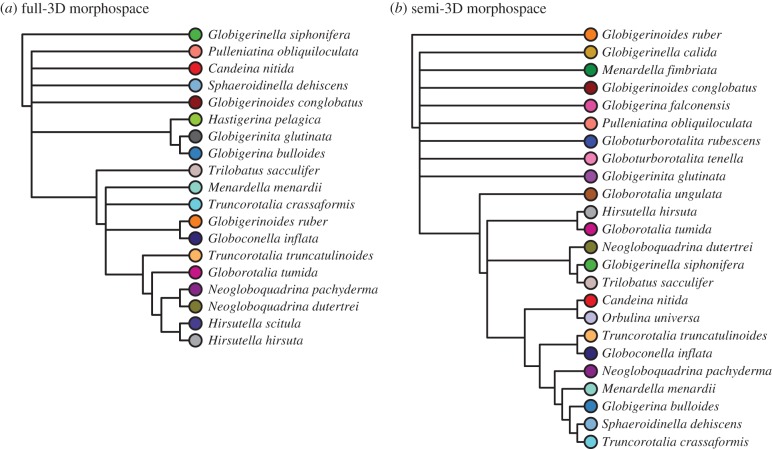
Majority-rule consensus cluster dendrograms for (a) the Tohoku University dataset and (b) our novel coretop exemplar dataset. Tip label colours correspond with species colours in the morphospaces depicted in figures 6 and 8a. The consensus dendrogram is constructed from five cluster dendrograms, each built from the same mean distance matrix using a different clustering algorithm (see text).